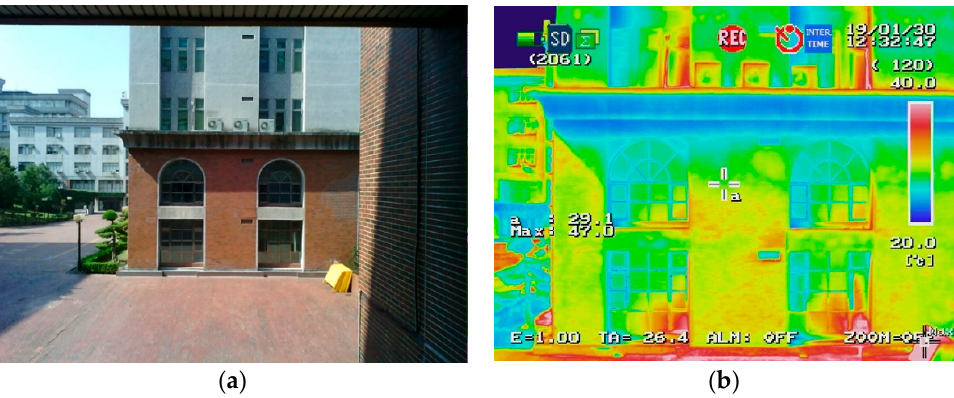
Figure 1. ( a ) The digital image of the building façade was recorded by InfReC R500Pro, and the image sizes are 960 × 1280 pixels. The parts of building were covered with shadow effects. ( b ) The corresponding thermal infrared image was taken by InfReC R500Pro, and the surface temperature information of the facade was recorded. The parts of the façade were covered with shadow effects, and the parts of the façade were exposed under the